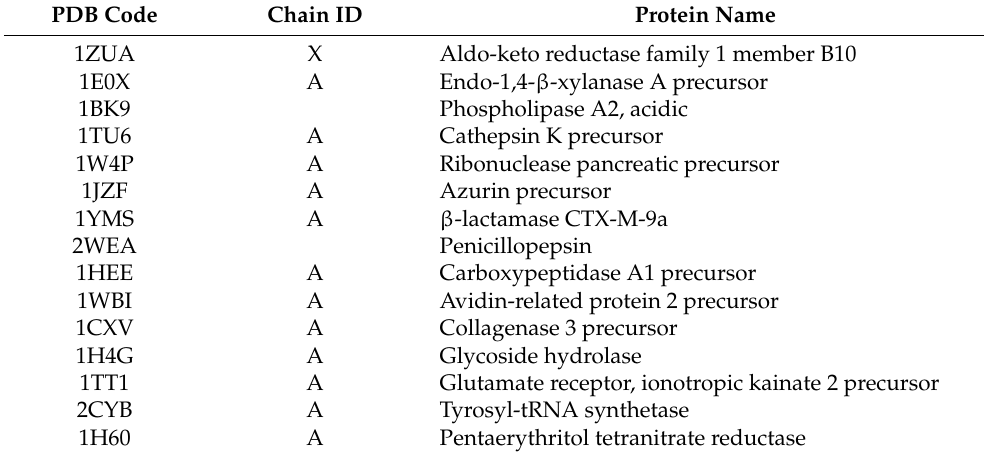
Table 1. The list of proteins utilized in this and originally collected by Soga et al.